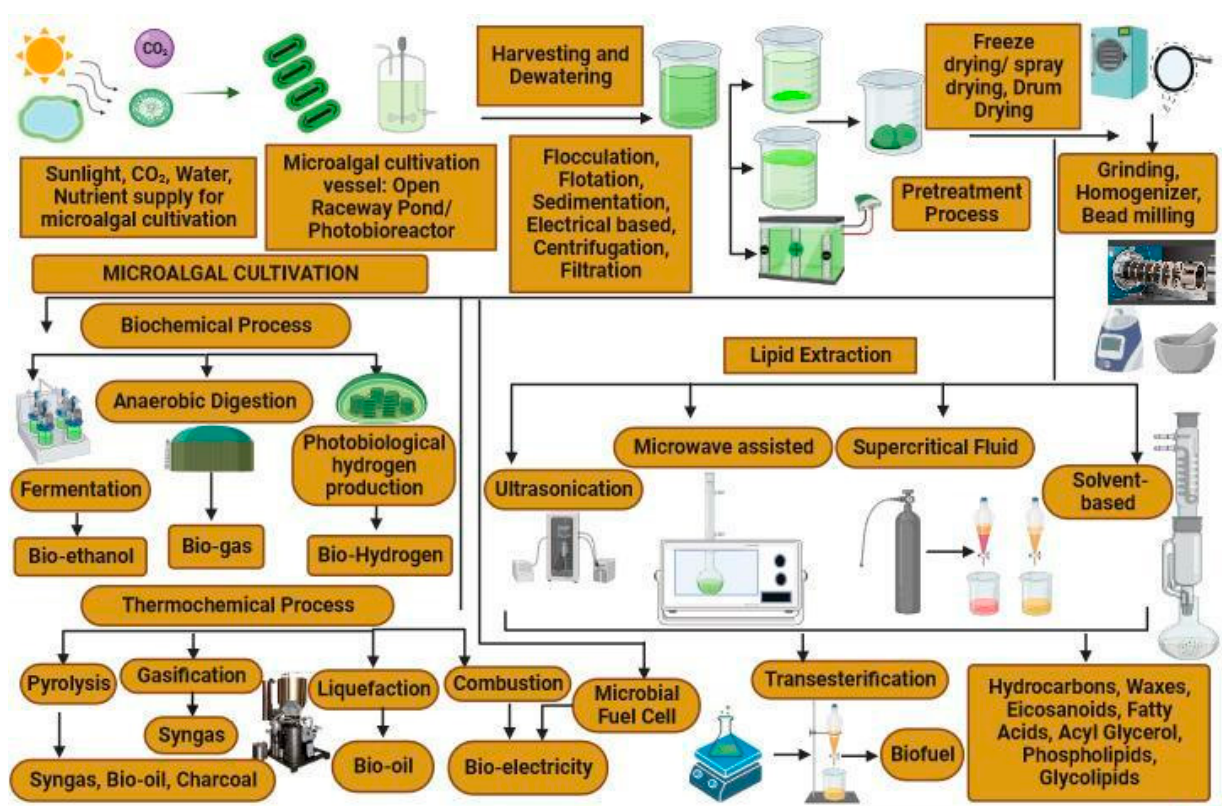
Figure 1. Schematic diagram for production of microalgal-based biorefinery products.